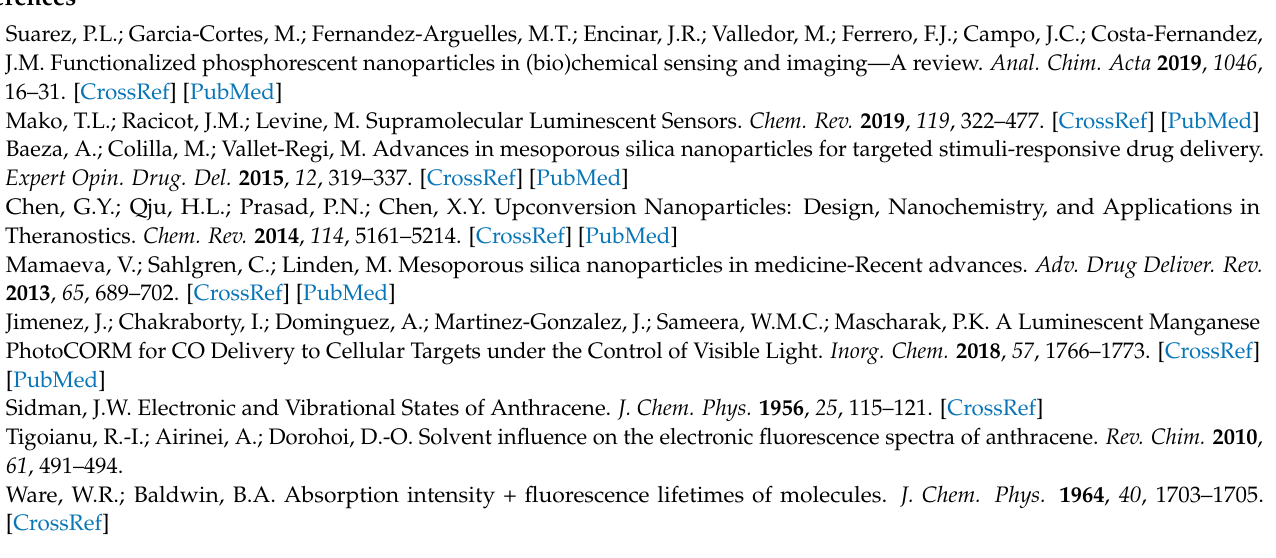
of [Mn III ]@NP, Figure S26: Emission spectra of [Mn III ]@NP, Figure S27: Area below the emission curve versus particle’s load of [Mn III ]@RSNP, [Mn III ]@SNP and [Mn III ]@CSNP suspensions and the corresponding fits with their equations, Table S1: Porosity data from nitrogen sorption isotherms for RSNP, SNP and CSNP, Table S2: Porosity data from N 2 -sorption isotherms for [Mn III ]@RSNP, Table S3: Porosity data from N 2 -sorption isotherms for [Mn II ]@RSNP, Table S4: Porosity data from N 2 -sorption Table S6: Porosity data from N 2 -sorption isotherms for [Mn III ]@CSNP, Table S7: Porosity data from N 2 -sorption isotherms for [Mn II